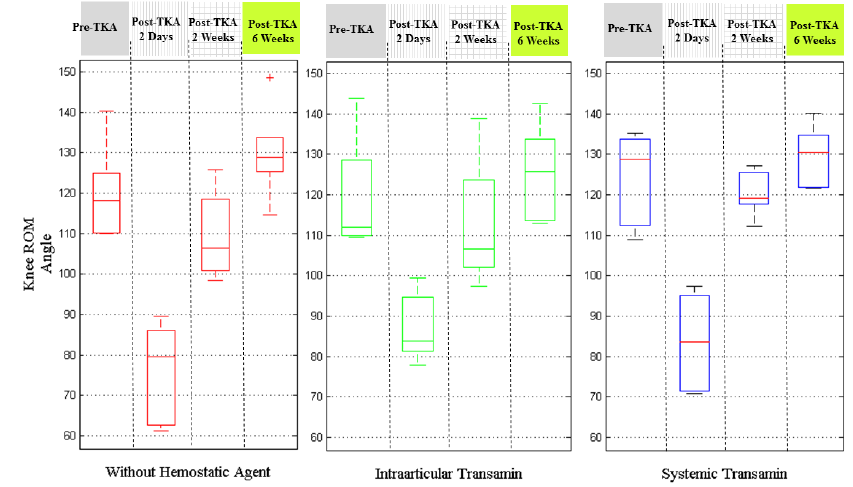
Figure 8. The recovery knee ROM between groups of patients differing in use of hemostatic agents.